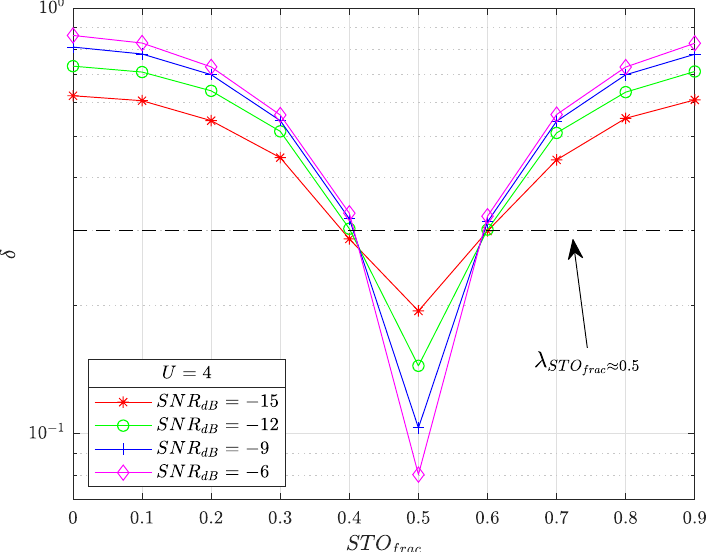
δ as a function of STO frac = (cid:104) (cid:105)